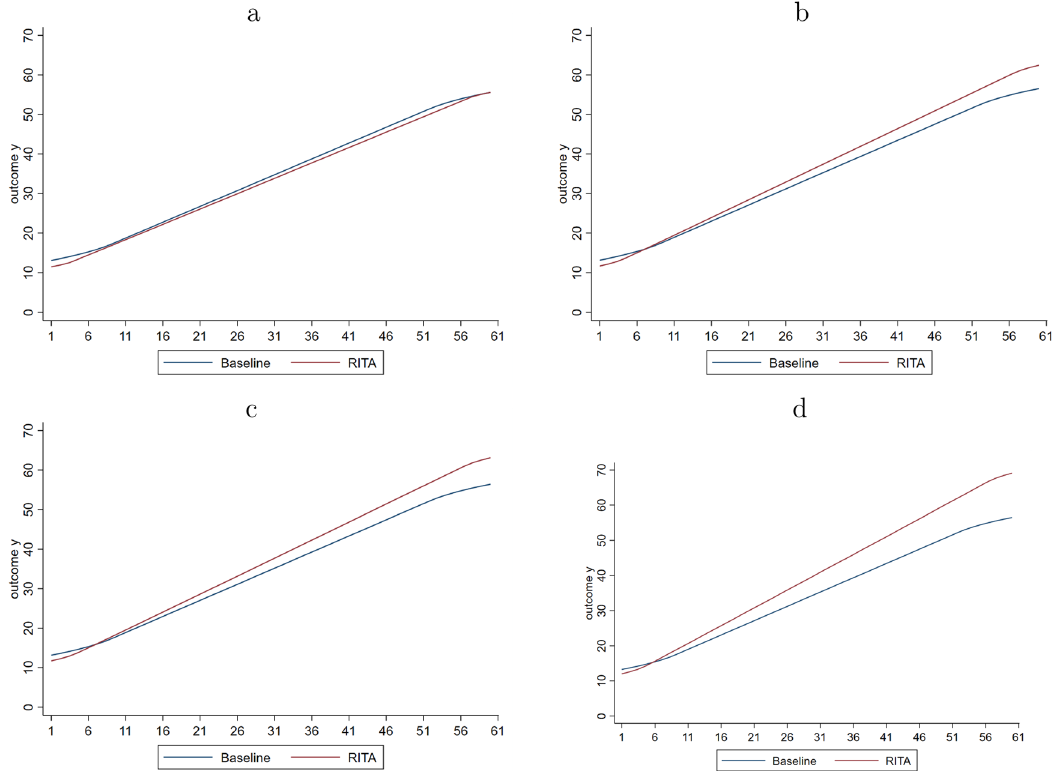
Fig. 4 Average cumulative outcomes. a Results for World 1. b Results for World 2. c Results for World 3. d Results for World 4.